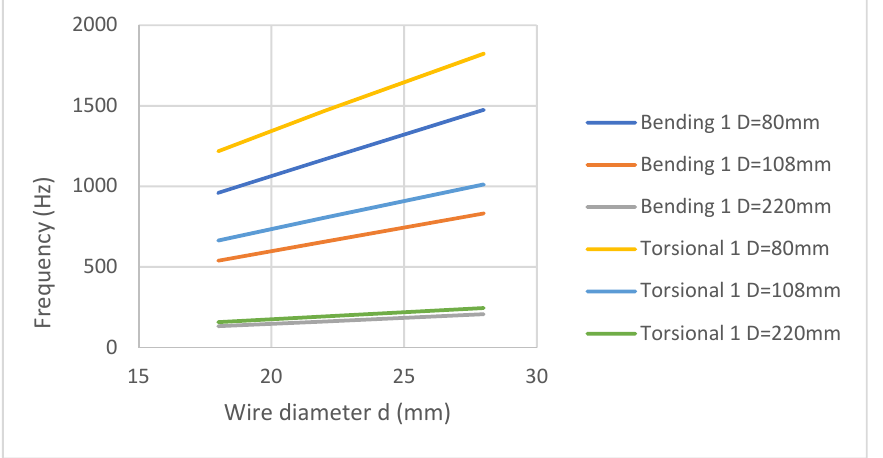
Figure 9. Sensitivity of the first resonance modes to the wire diameter, d.